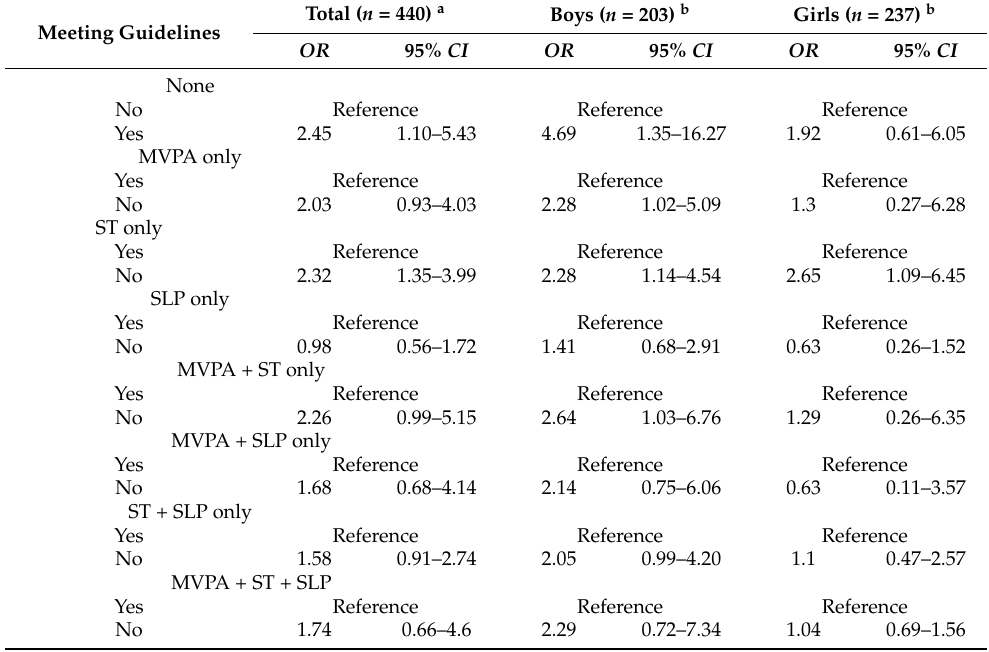
Table A5. Associations between meeting the 24-Hour Movement Guidelines and overweight and obesity in Chinese children and